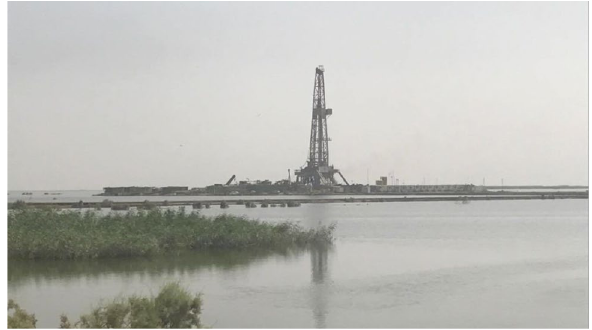
Fig. 5 The border wetlands of